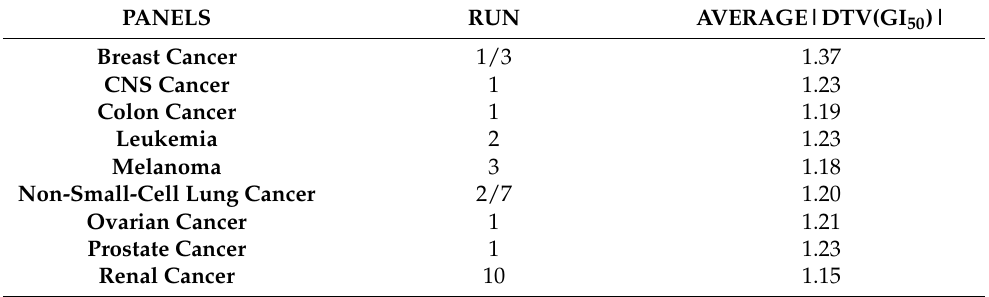
Table 3. Best parameter combinations for each panel.